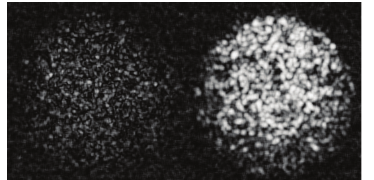
Figure 8: Estimates of 𝑃 2 using the 3 low flux intensity images 𝑁 𝑁 𝑁 1 , 2 , and 3 for the real polarimetric images for an estimation window of size 𝑛 = 9 × 9 . “MLE”: maximum likelihood